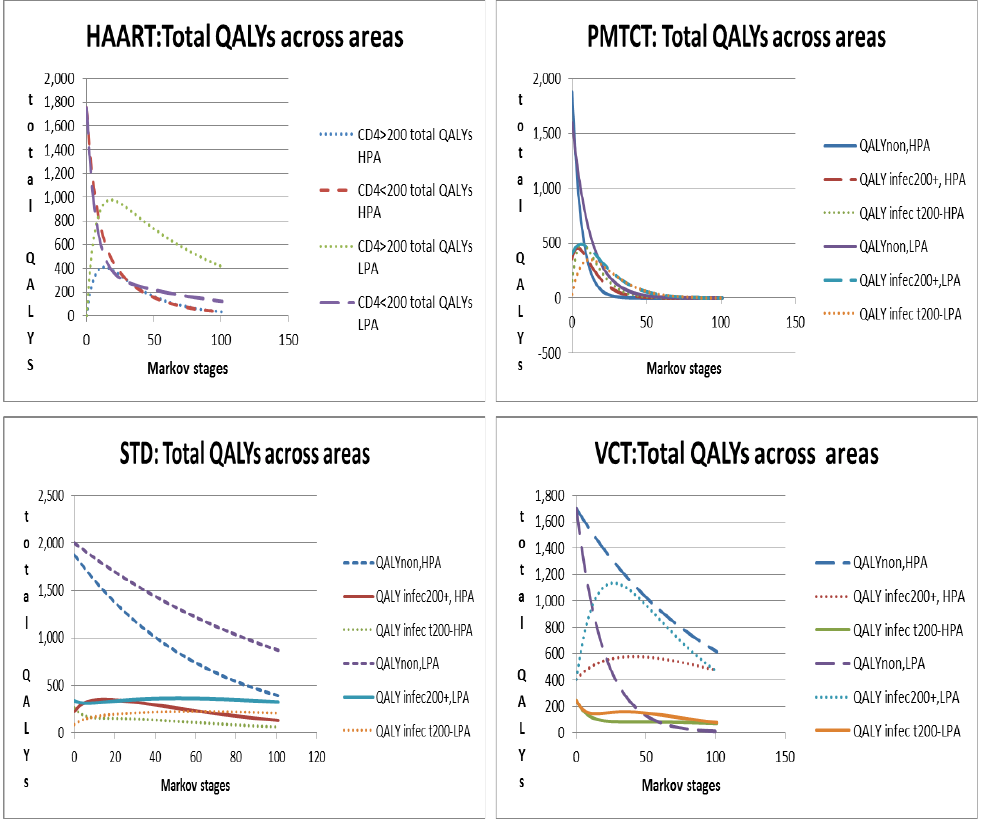
Comparisons of quality adjusted life years across an LPA and a